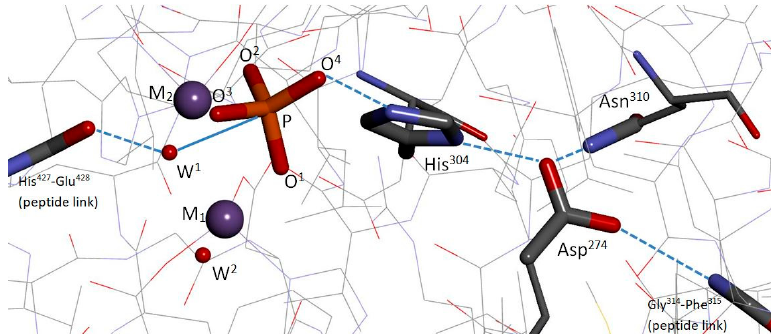
Figure 1. The PP5 / phosphate co-crystal (pdb entry 1S95 [13]) and its implications for phosphoester hydrolysis. The phosphate ion’s O 1 and O 2 are coordinated to two Mn 2+ ions, M 1 and M 2 , respectively. W 1 is the oxygen of what is now accepted to be a bridge hydroxide. The hydroxide is oriented by the peptide carbonyl at left and is positioned along the P-O 4 axis (solid line) for a backside attack, theoretically, on the central P atom of a similarly bound phosphoester. N ϵ of His 304 is almost certainly protonated, and O 4 marks what would be a seryl/threonyl O γ requiring a proton as the phosphoester bond breaks. The His 304 / Asp 274 tandem is coupled by an H-bond, and Asp 274 is additionally H-bonded to Asn 310 and the -NH moiety of the peptide link at right. W 2 is the oxygen of a water / hydroxide ligated to M 1 . Dashed lines indicate H-bonds.